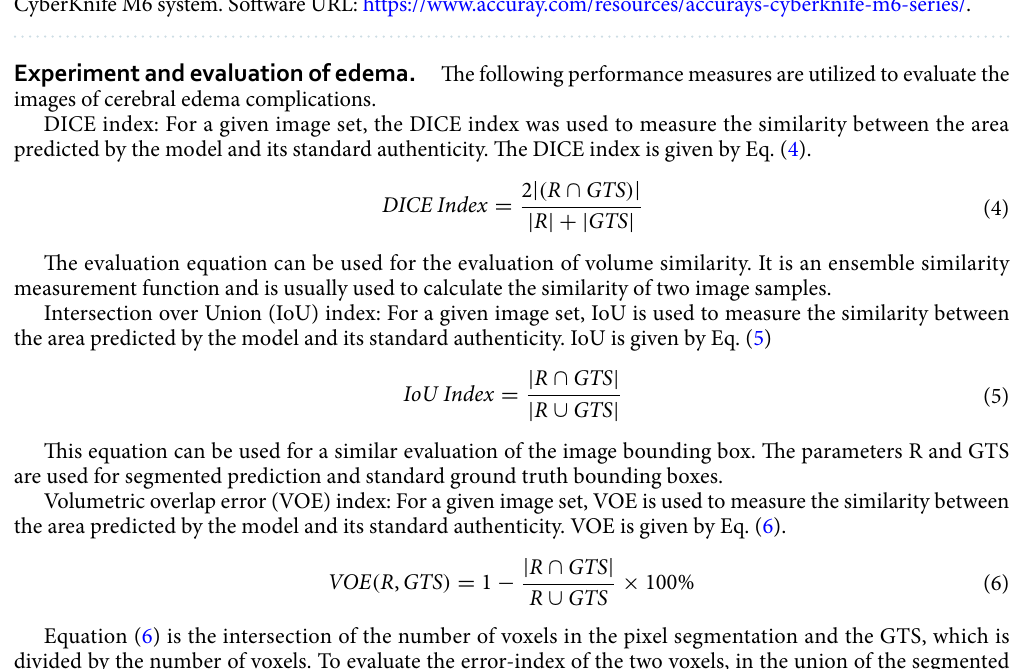
Figure 5. Cerebral edema Complications GTS image comparison between region growing and Mask R-CNN method. Panel ( a – d ) show the 2D segmentation result by Region growing method of cerebral edema complication image at 150, 205, 180, 215 layer. Panel ( e – h ) show the 2D segmentation result by Mask R-CNN model of cerebral edema complication image at 150, 205, 180, 215 layer. GTS ground truth segmentation, R-CNN region-based convolutional neural networks. Image source statement: This image was created using CyberKnife M6 system. Software URL: https:// www. accur ay. com/ resou rces/ accur ays- cyber knife- m6-